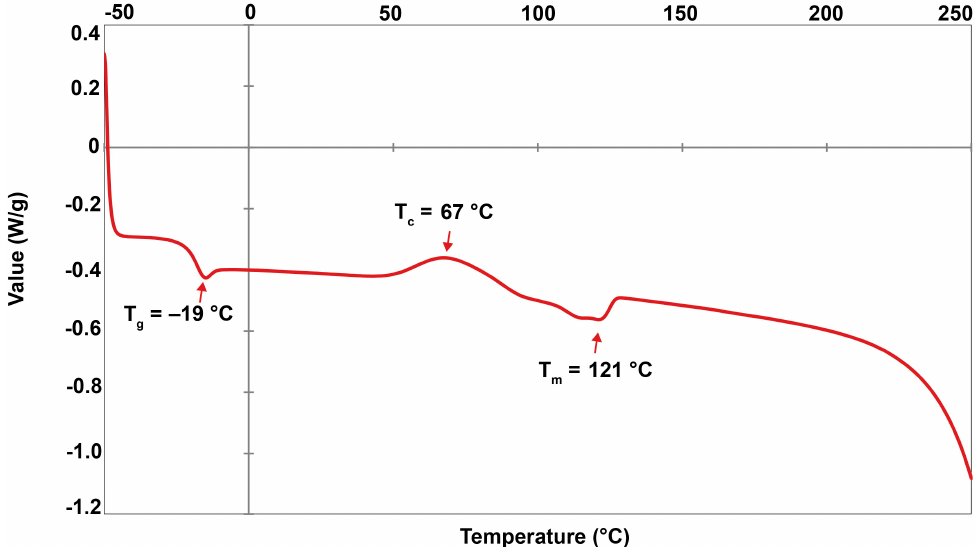
Figure 10. Differential Scanning Calorimetry (DSC) of PHBV from Cyanosarcina sp. AARL T020; Tm , melting temperature; T c , thermal crystallization temperature; T g , glass transition temperature.